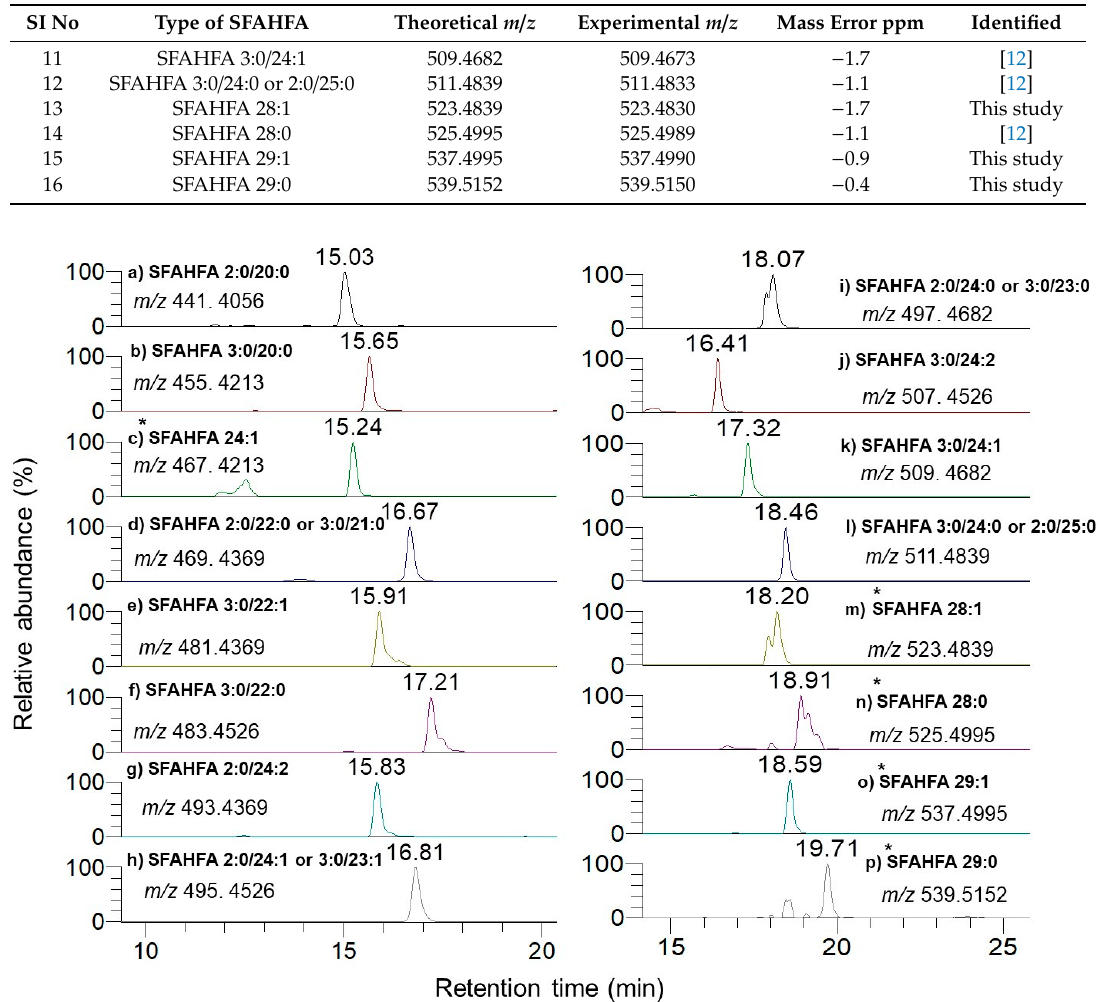
Figure 2. Extracted ion chromatograms of DMED-labeled SFAHFAs (* represents the SFAHFAs for which MS / MS data was not acquired).